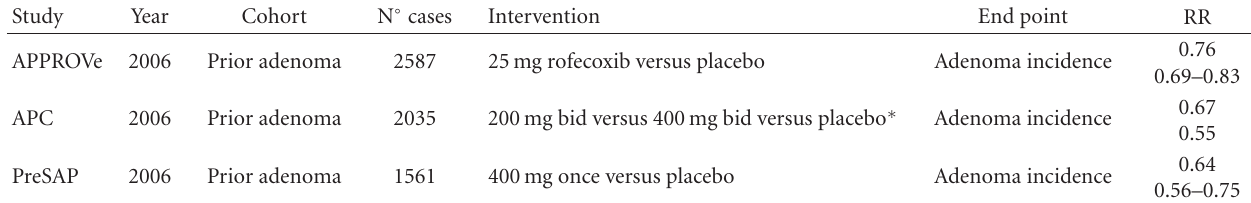
Table 2: Results in adenoma incidence in COXIB